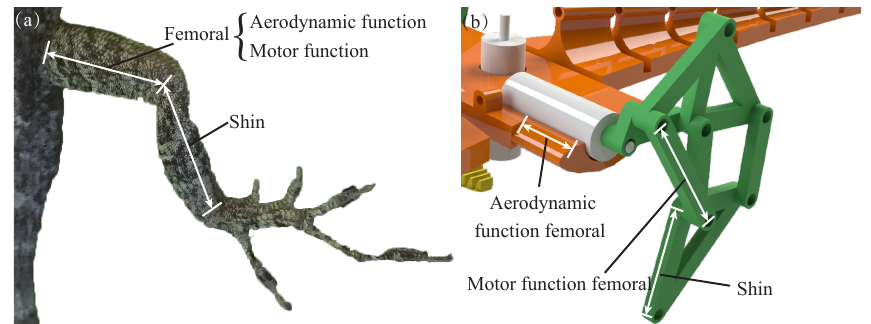
Figure 8. ( a ) Photograph and ( b ) simplified limb model of the anole leg.